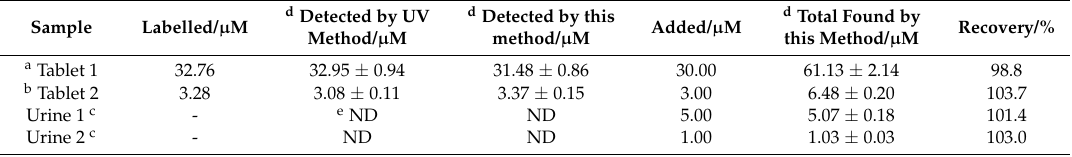
Table 5. Rutin detection results from compound rutin tablets and urine samples ( n =